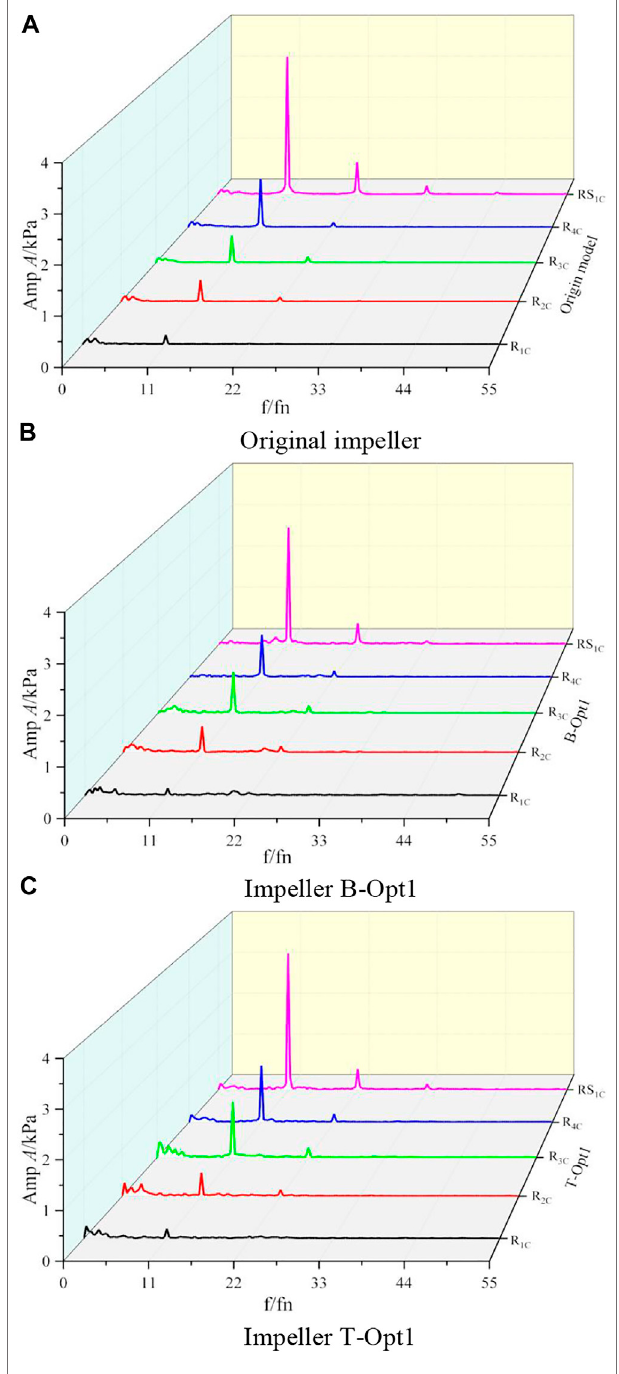
FIGURE17| Frequency-domaincharacteristicsofpoints R 1C ~R 4C and RS 1C . (A) Original impeller. (B) Impeller B-Opt1. (C) Impeller T-Opt1.